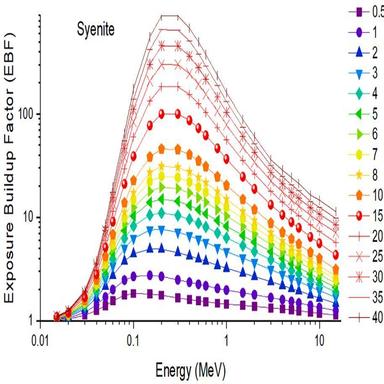
Variation of exposure buildup factor (EBF) values of syenite as a function of photon energy (MeV).